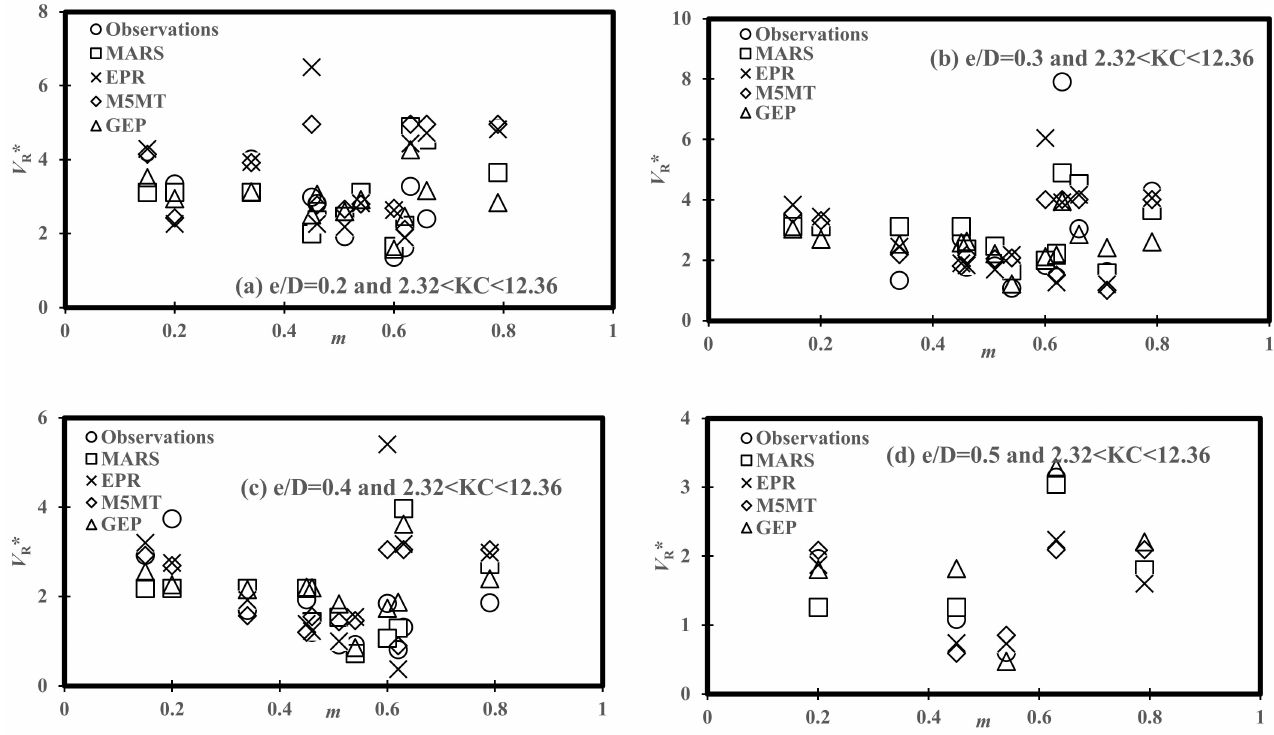
Figure 7. Comparisons of the soft computing models’ performance for variation of V R * versus m in for various levels of e / D : ( a ) e / D = 0.2, ( b ) e / D = 0.3, ( c ) e / D = 0.4, and ( d ) e / D =